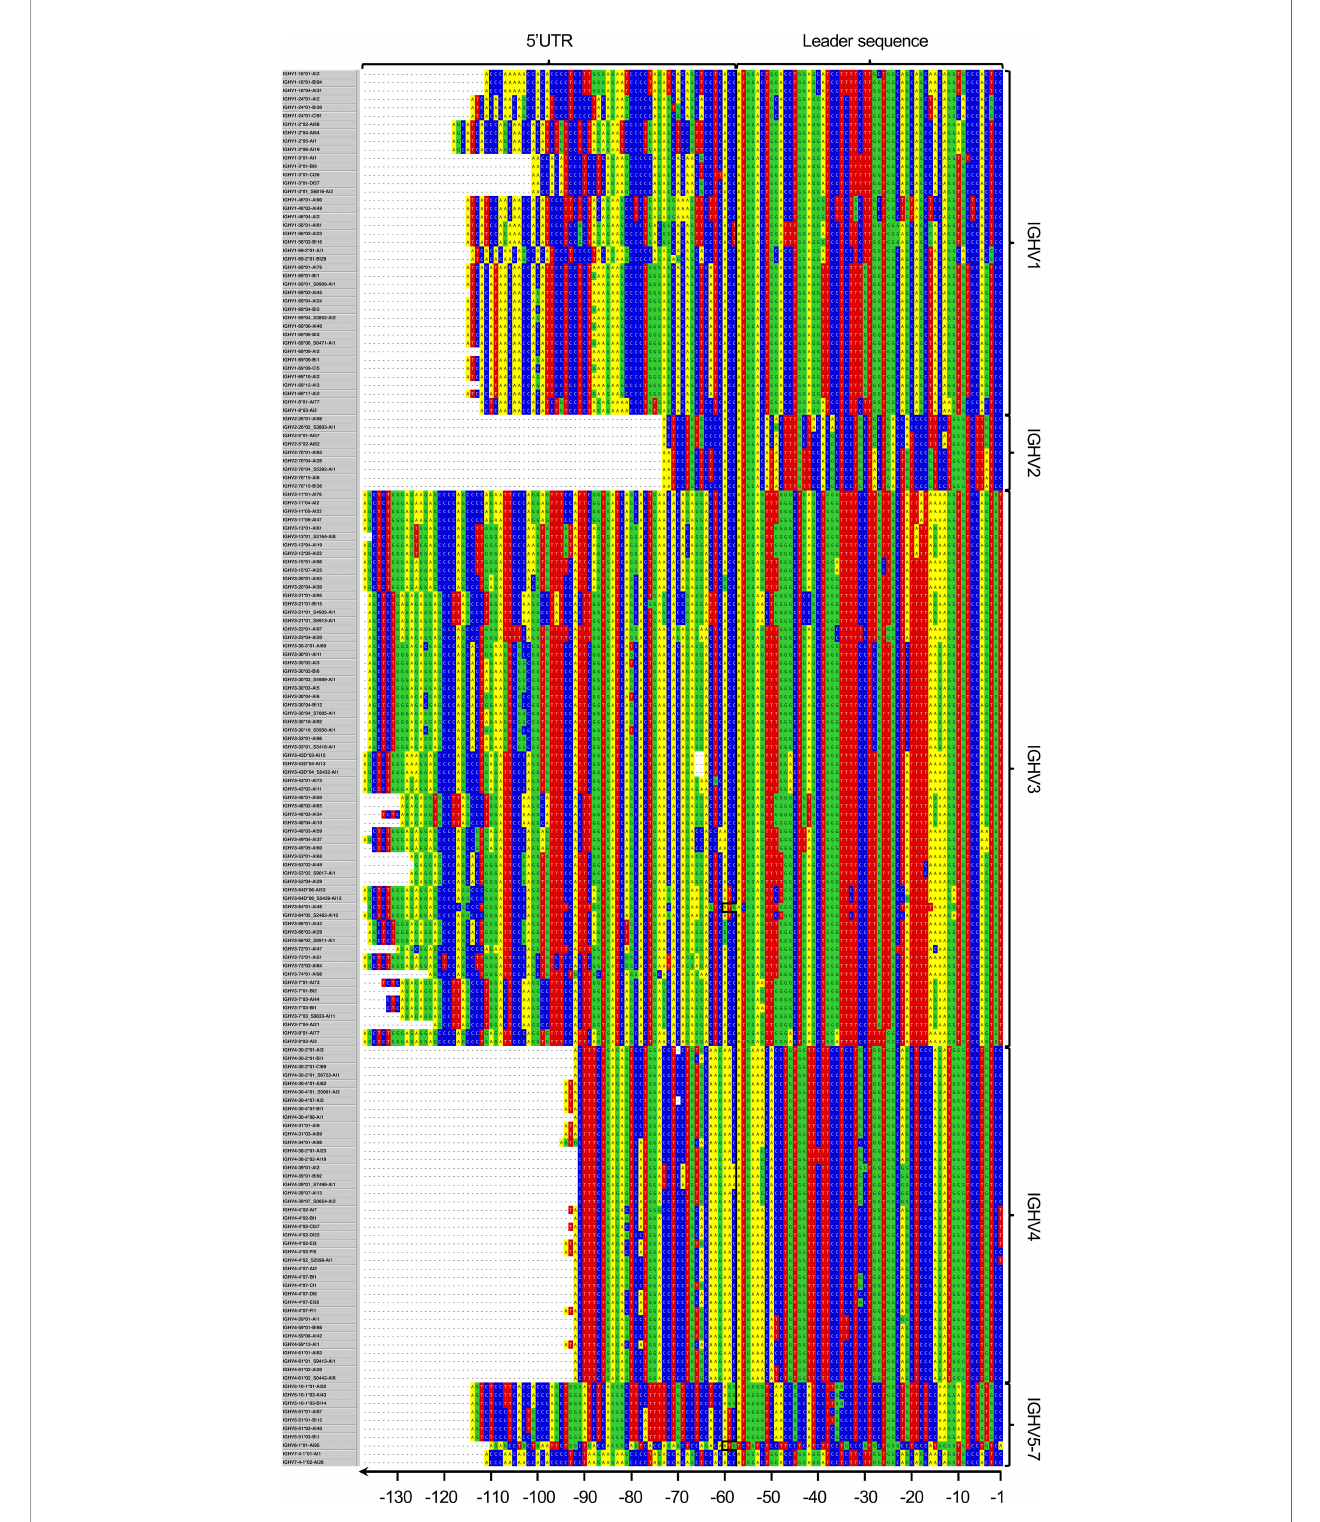
FIGURE 2 | Overarching 5 ’ UTR-leader sequence germline data set inferred in the present study. In addition, upstream regions of IGHV1-3*02 and IGHV4-4*01 have been identi fi ed in a separate study